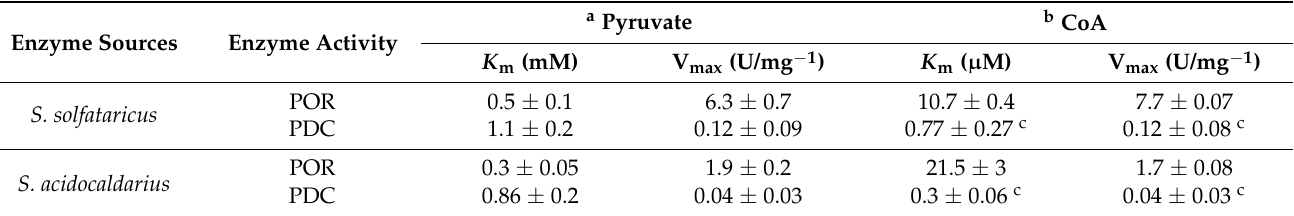
Figure 5. The pyruvate and CoA dependency of the PDC activities of the bifunctional POR/PDCs from S. solfataricus ( A , B ) and S. acidocaldarius ( C , D ). The CoA dependency (( A , C ) 0.0 to 100 µ M in the presence of 100 mM sodium phosphate [pH 7.9] and 10 mM pyruvate) and pyruvate dependency (( B , D ) 0.0 to 10 mM in the presence of 100 mM sodium phosphate [pH 7.9] and 100 µM CoA) were performed at 80 °C. Table 3. Kinetic parameters of the POR and PDC activity of the bifunctional POR/PDCs from S. solfataricus and S. acidocaldarius